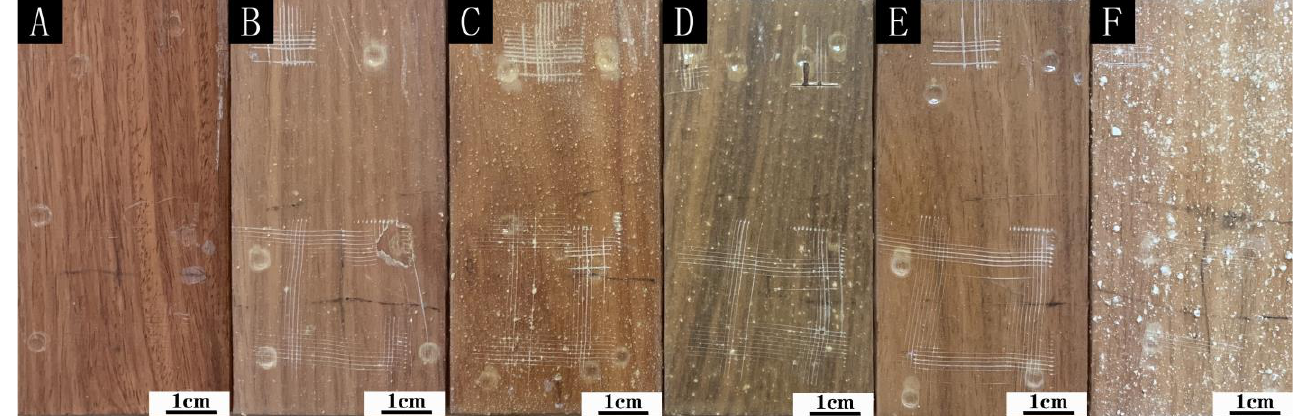
Figure 5. Morphology of paint film on the surface of basswood prepared with different emulsifiers ( A ) without microcapsules, ( B ) Span-80, ( C ) SDBS, ( D ) OP-10, ( E ) Tween-80, ( F ) SDS.